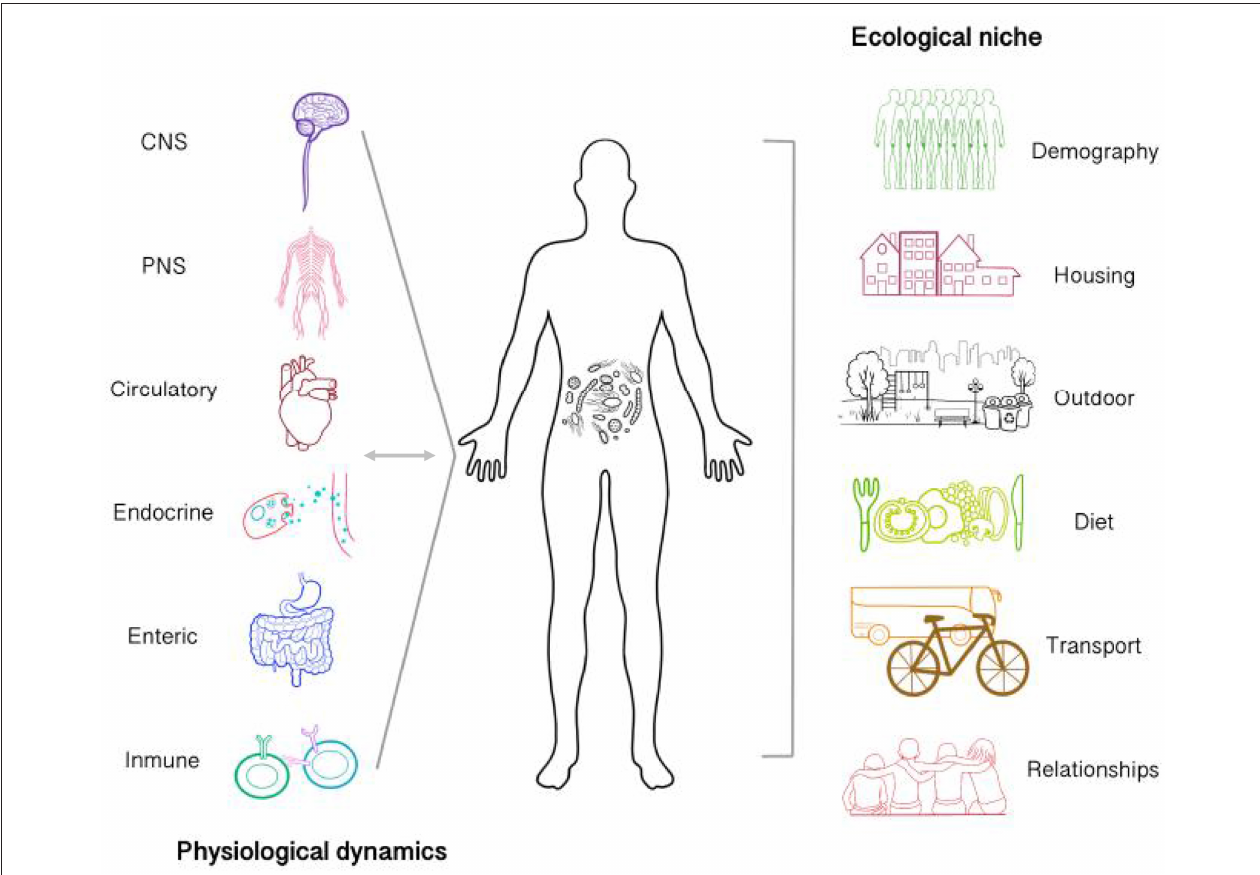
FIGURE 1 | Microbiota establishes bi-directional relationships with physiological processes of the body and is affected by the ecological niche of which an agent participates. Gut microbiota interacts with other systems via neural and humoral pathways (Central, enteric and peripheral nervous system, immunoendocrine pathways, etc.). Possible communication mechanisms involve the regulation of neurotransmitter metabolism, gut permeability, nutrient processing and absorption, inflammatory cytokines release, the stress response, etc. Therefore, internal microbiota dynamics are actively affecting body dynamics in a process which in turn is also affecting microbiota. Microbiota in not only affected by internal processes but also by the agent’s ecological niche. The features of the environment at different levels might be limited for the colonization and establishment of specific microbiological communities. Some environmental features which could be relevant includes the amount of people, the presence of the urban green space, urban hygiene, etc. Additionally, the ways by which the subject interact with it such as transportation, diet, and interpersonal relationships would also provide relevant information to take into account at the moment of carrying out interdisciplinary microbiota